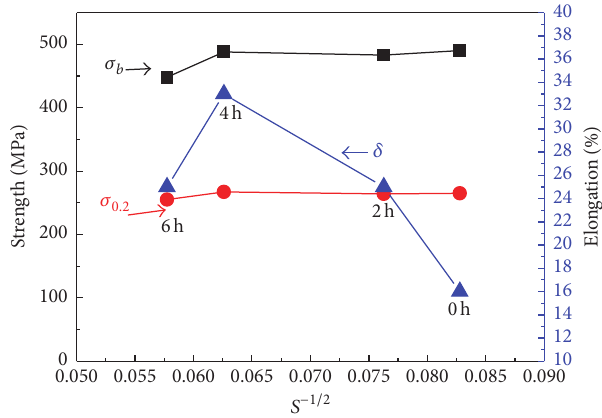
Figure 11: The variation of tensile strength, yield strength, and per- cent elongation with the inverse of the square root of interlamellar spacing, 𝑆